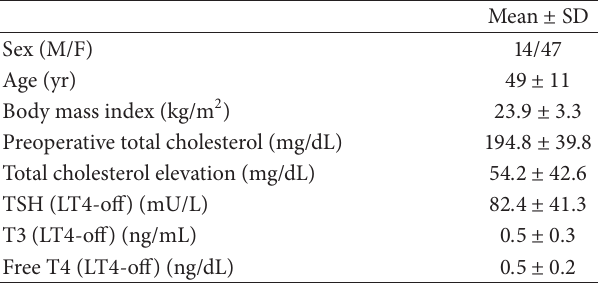
Table 1: Clinical and metabolic characteristics of the 61 patients.